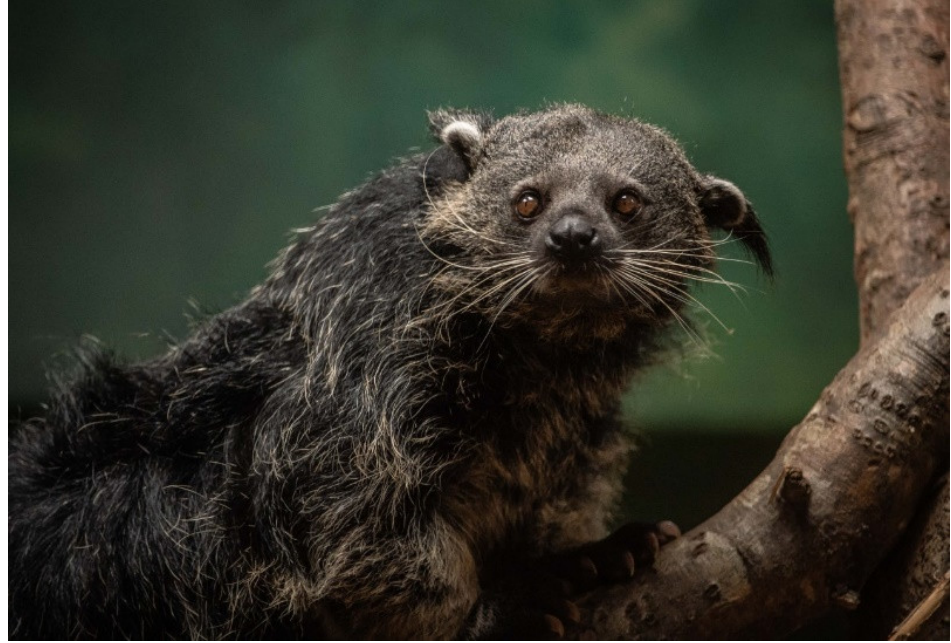
Figure 1. Palawan binturong ( Arctictis binturong whitei ) housed at Chester Zoo.